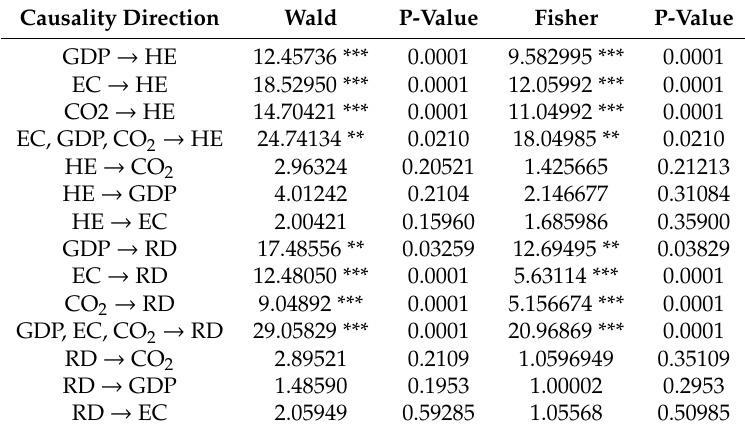
Table 8. Strong Causality